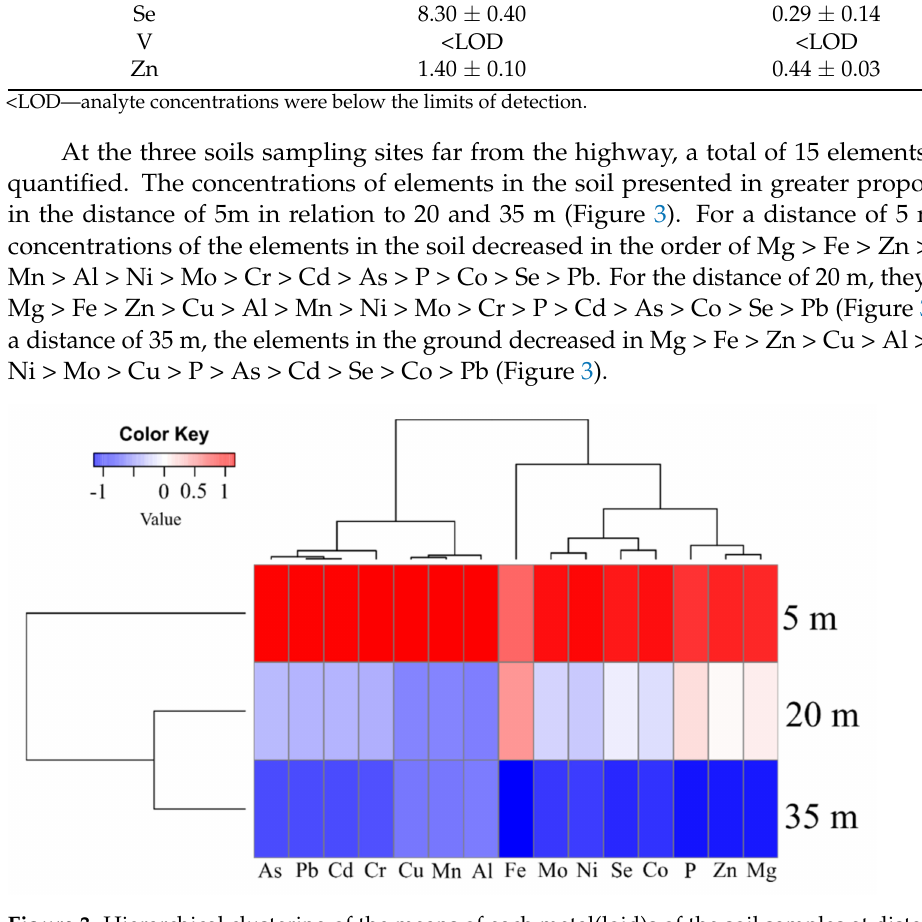
Figure 3. Hierarchical clustering of the means of each metal(loid)s of the soil samples at distances of 5, 20 and 35